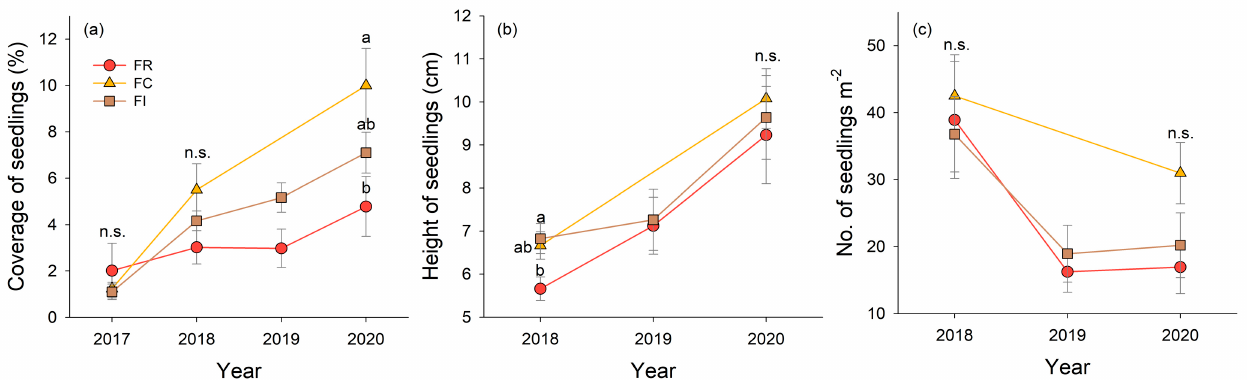
Figure 7. Reestablishment of S. borealis seedlings in flowering stands. ( a ) Coverage, ( b ) height, and ( c ) density. The values are average ± standard error. Difference between the three types was tested by ANOVA within a year except for 2019. The values with the different letters indicate significant difference at p < 0.05. n.s.: not significant. FR: flowering and rooting, FC: flowering and cutting, FI: flowering and intactness.